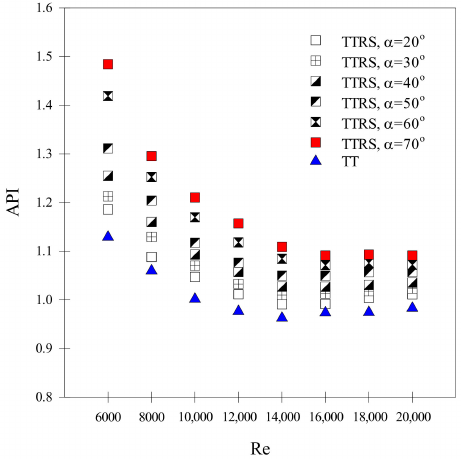
Figure 7. Effect of the twisted tapes in rib and sawtooth form vortex generator (TTRS) at varying sawtooth angles ( α ) on the aerothermal performance